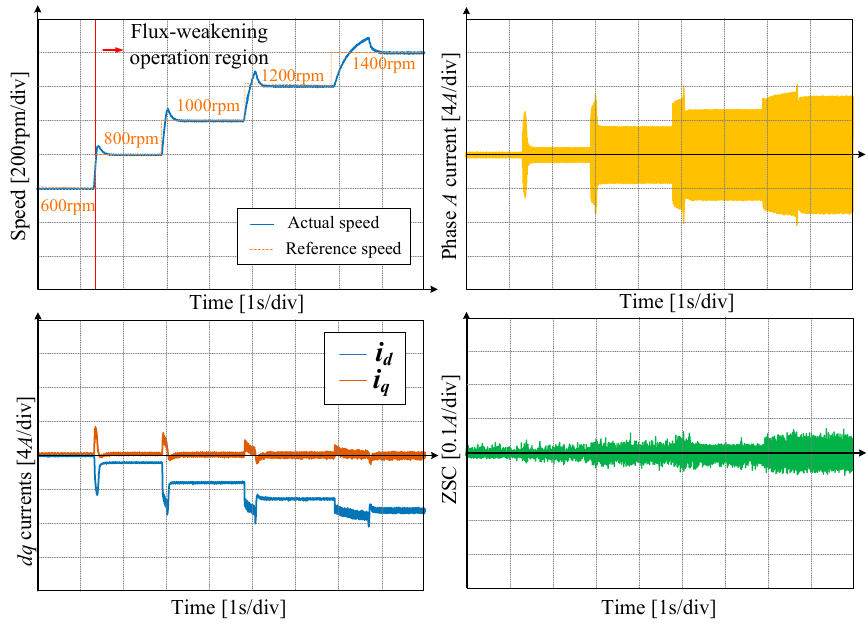
Figure 20. Dynamic performance of FW-DFVL under no load.